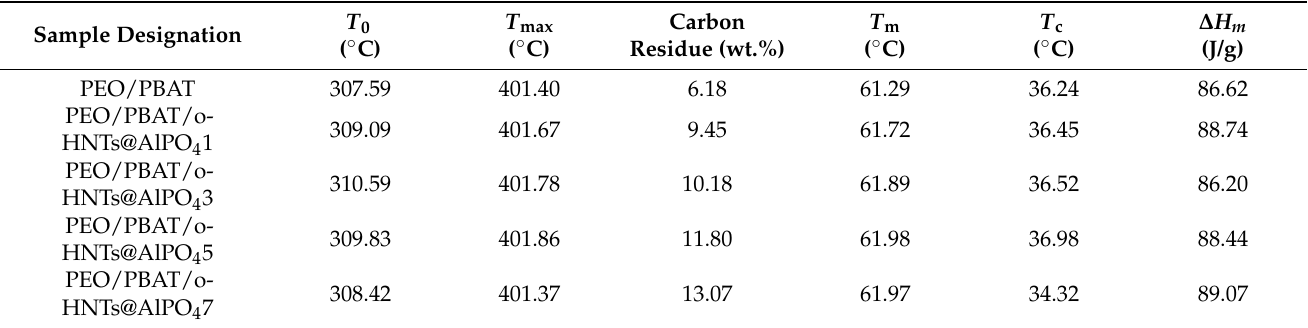
Table 3. Data of the TG and DSC of the PEO/PBAT/o-HNTs@AlPO 4 films.